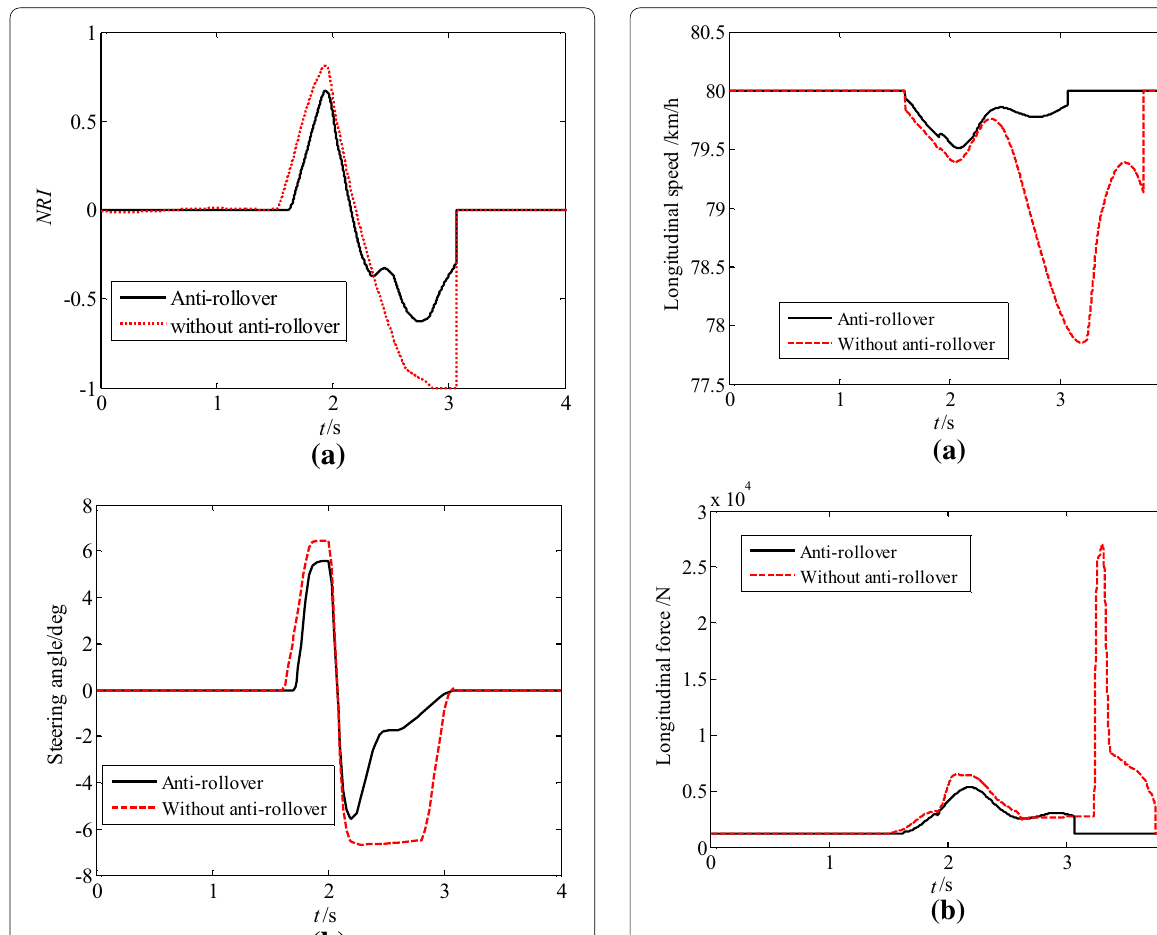
Figure 8 Longitudinal dynamics of the intelligent heavy truck in Scenario 1: ( a ) Longitudinal speed; ( b ) Longitudinal